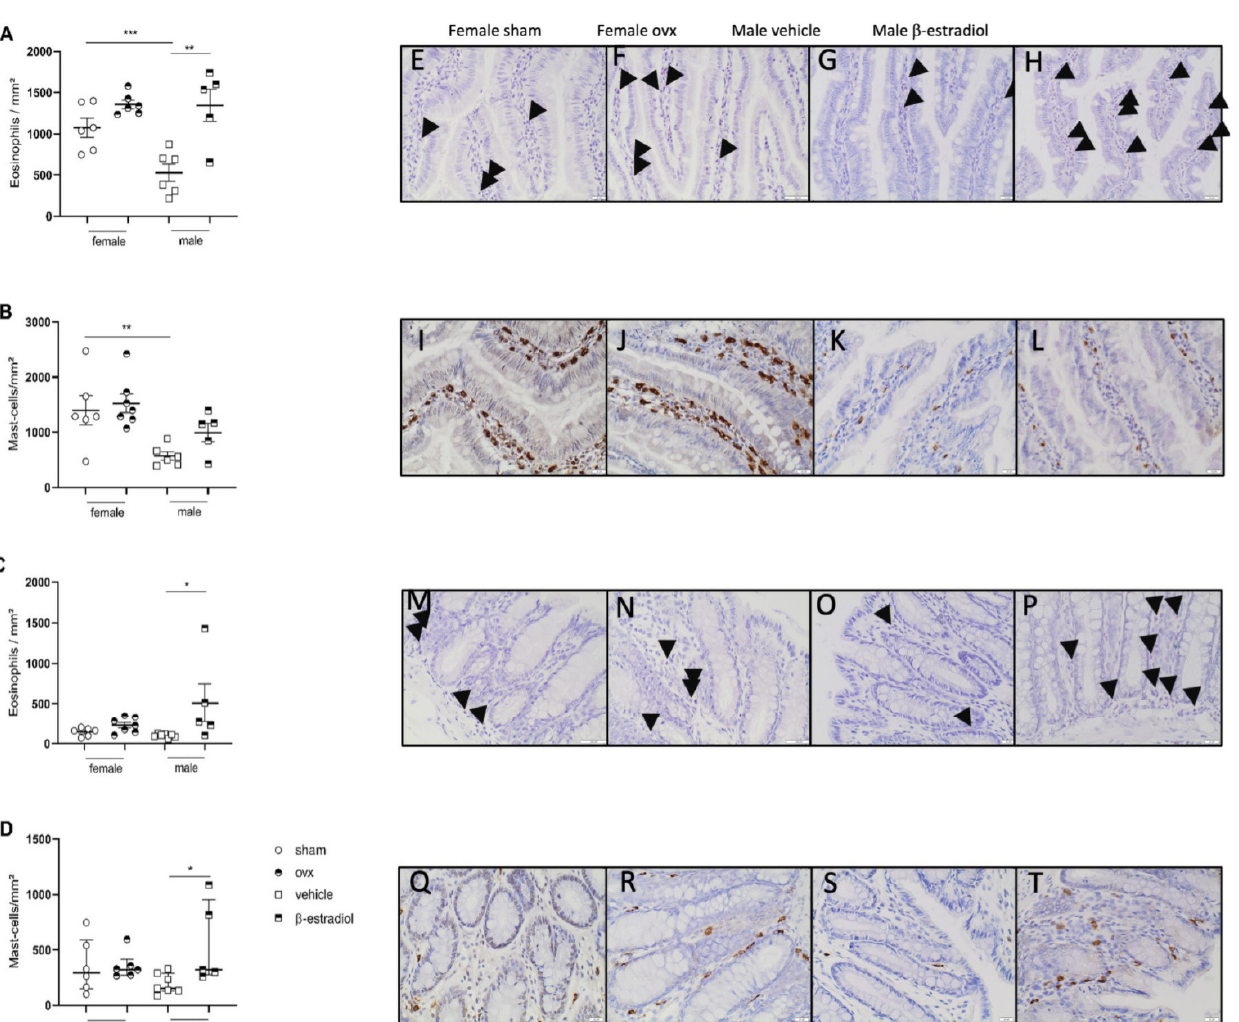
Figure 7. Effect of estrogen on immune cell infiltration in the jejunum and colon after maternal separation. Eosinophils stained by chromotrope2R in the jejunum ( A ) and the colon ( C ) of MS BBDP-N males injected with vehicle or β -estradiol and in females after sham surgery or ovariectomy. Mast cells stained by immunostaining in the jejunum ( B ) and colonic mucosa ( D ). Representative pictures of eosinophils infiltration in the jejunum for female sham ( E ); female ovx ( F ); male vehicle ( G ); male with β -estradiol ( H ) and for the colon for male NH ( M ); female NH ( N ); male MS ( O ); female MS ( P ). Representative pictures of mast cells infiltration in the jejunum for female sham ( I ); female ovx ( J ); male vehicle ( K ); male with β -estradiol ( L ) and for the colon for male NH ( Q ); female NH ( R ); male MS ( S ); female MS ( T ). Eosinophils are indicated by arrows. Data are expressed as mean ± SEM or median with IQR ( D ) * p < 0.05; ** p < 0.01; *** p < 0.001. ovx—ovariectomy. n = 5–7 per group.